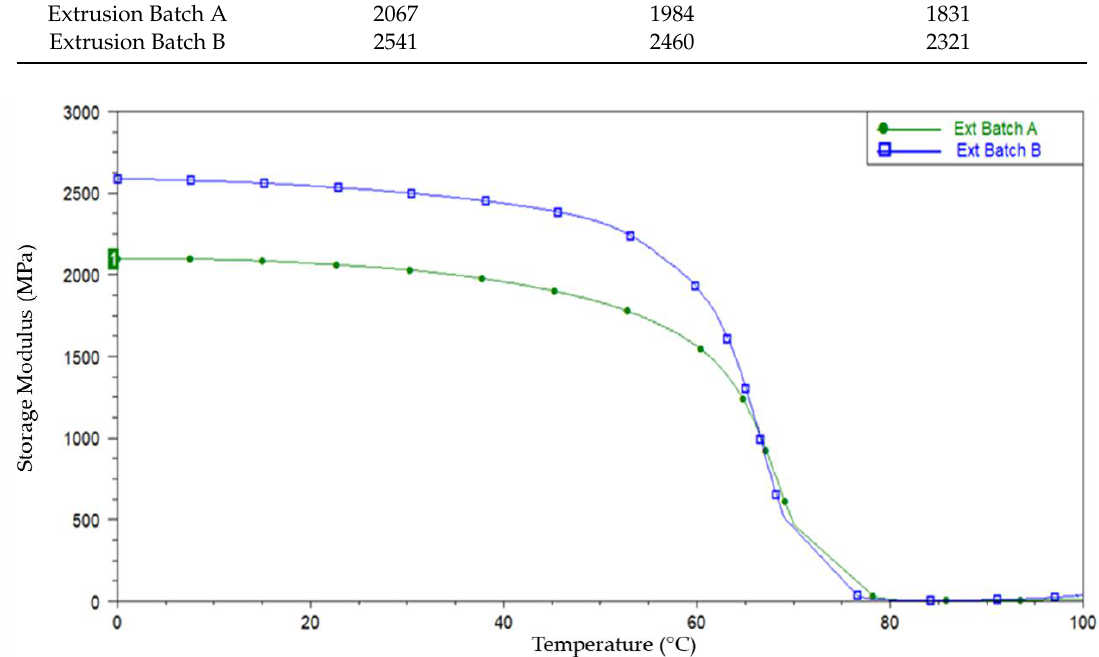
Figure 10. DMA plot of storage moduli from Batch A and B extruded tubes.